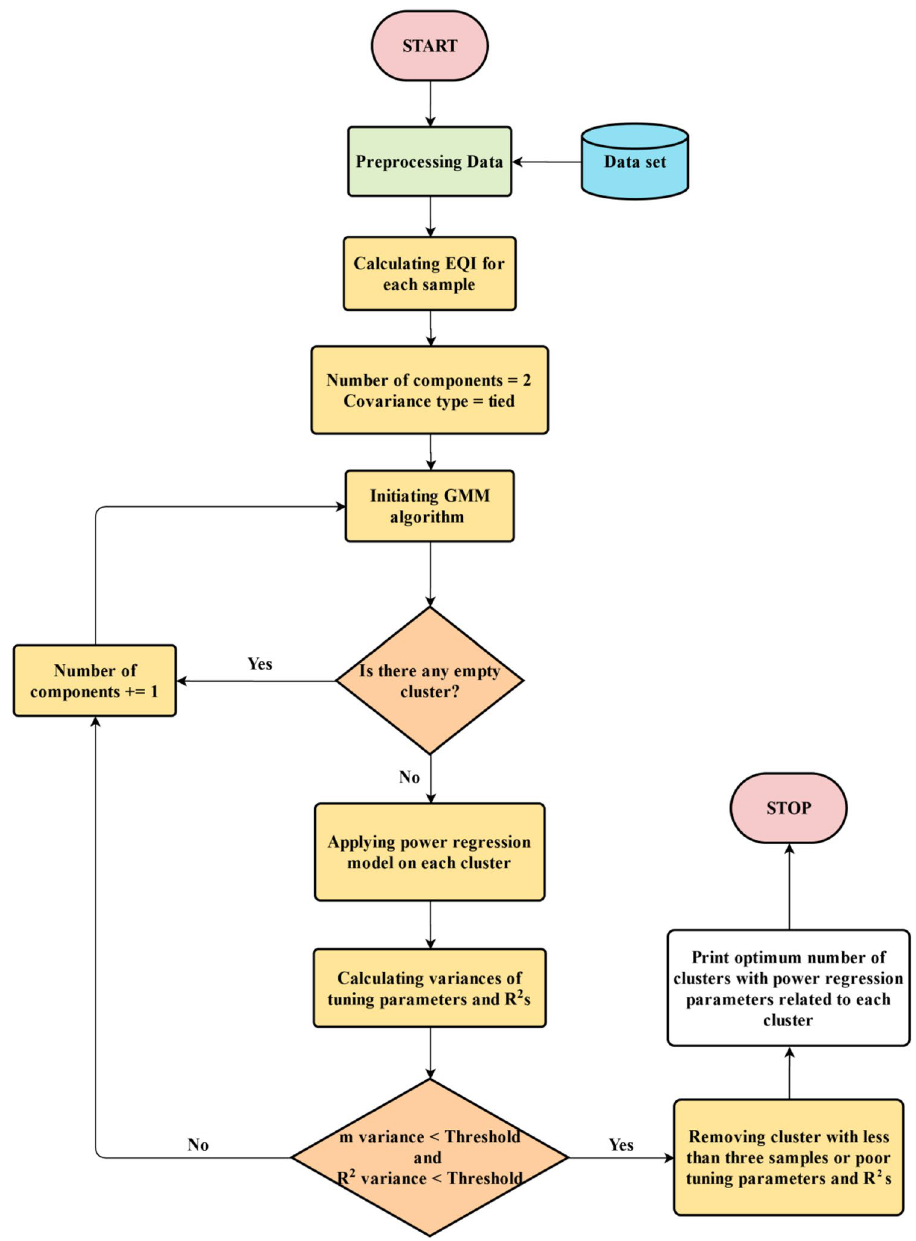
Fig. 2 Flowchart of the pro- posed EQI-based clustering